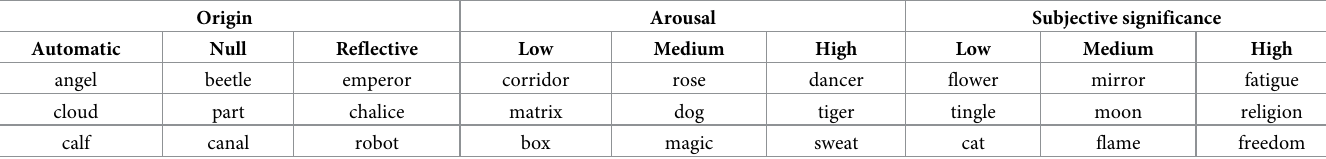
Table 1. Some examples of words differing in their origin, arousal and subjective significance levels; the full list of words is presented in S1